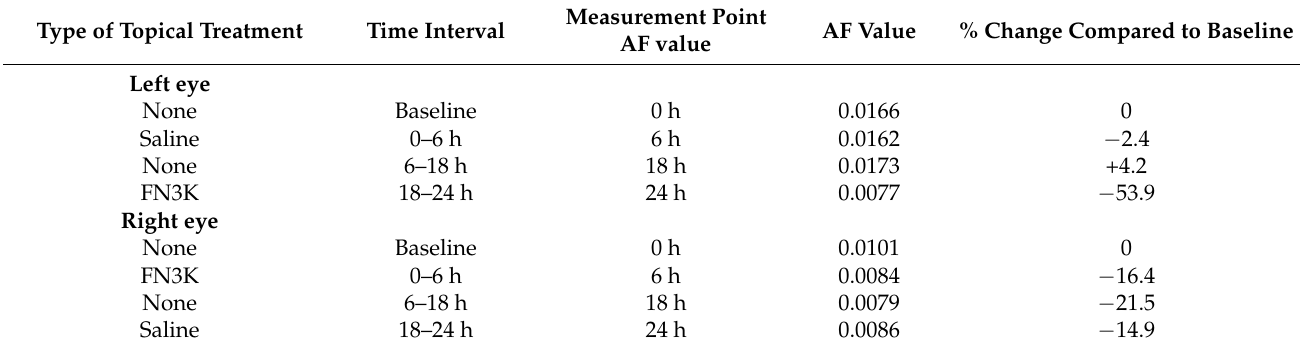
Table 1. Maillard-type autofluorescence values (AF values) after crossover topical treatment with a saline and FN3K solution of post-mortem eyes from a 78-year old cataract patient. Type of Topical